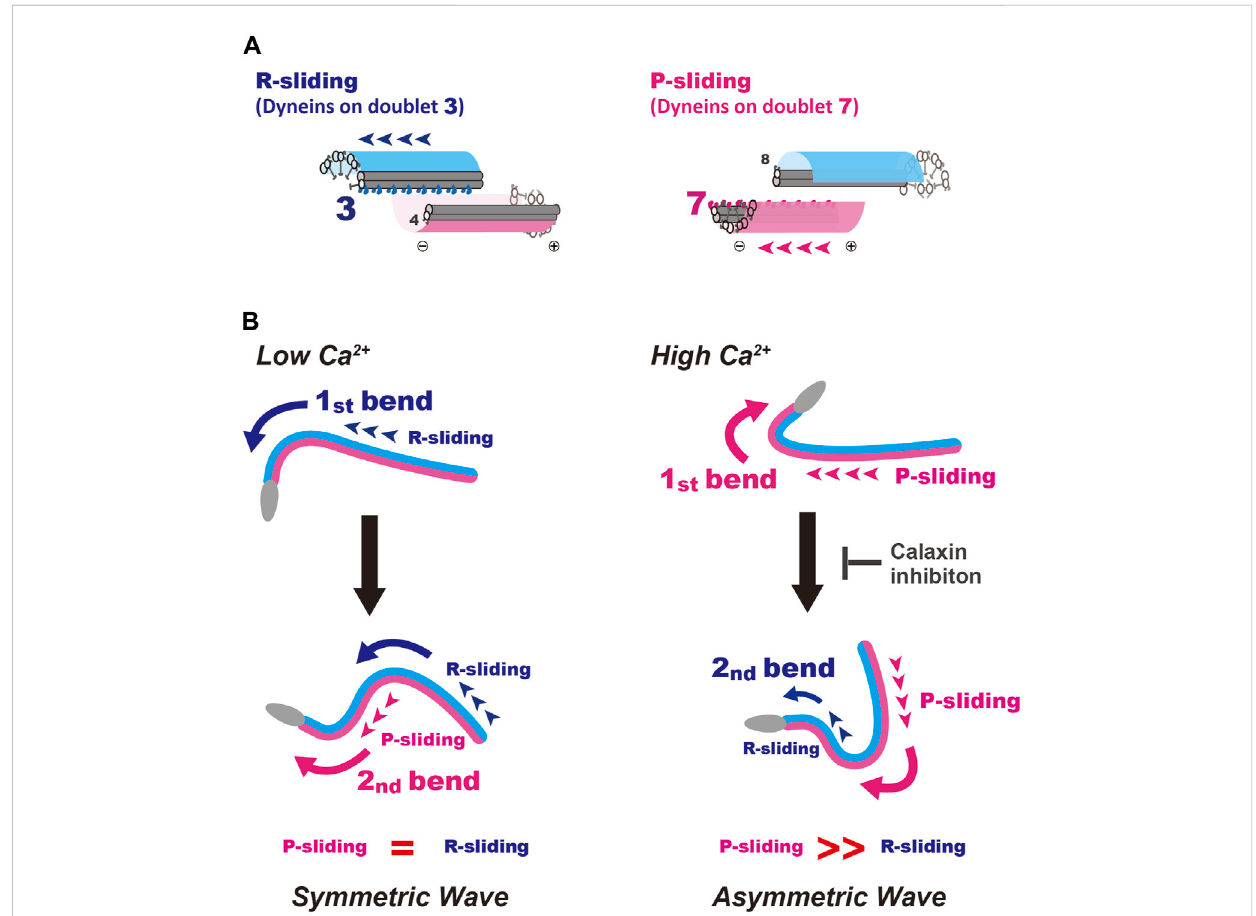
FIGURE 6 A model for the formation and propagation of the fi rst bend and second bend in symmetric and asymmetric sperm fl agellar waves. (A) Schematic representation for the R- and P-sliding in relation to the number of active dynein on doublet microtubule. Based on the studies of sea urchin and mammalian sperm. The formation of P-bends and R-bends is induced by the activation of dyneins on doublet 7 and 3, respectively. (B) A putative mechanism forinitialbendformationanditspropagationunderlowandhighCa 2+ conditionsareshown.Left, formationofasymmetricwaveunder low Ca 2+ conditions. The fi rst bend is formed by R-sliding. In turn, this R-bend induces switching of active dynein to that on the opposite side across the axoneme, resulting in P-sliding to form a P-bend. Right, generation of an asymmetric wave under high Ca 2+ conditions. P-bend is fi rst formed by P-sliding.Inturn,thisP-bendinducestheswitchingofactivedyneintothatontheoppositesideacrosstheaxonemeandgeneratessuppressed R-sliding toformaR-bendwithsmallercurvature,resultinginthepropagationofanasymmetricwave.Acalaxininhibitor,repaglinide,suppressesthegenerationof R-bend, possibly by inhibiting the mechanical transmission from P- to